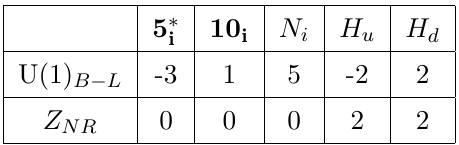
Table 1 . Charge assignment of MSSM particle